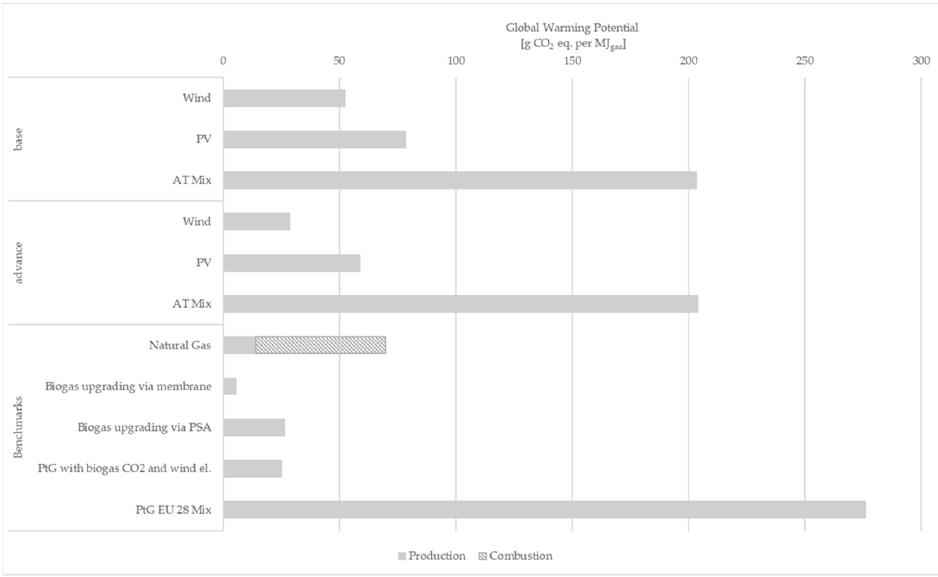
Figure 16. Global Warming Potential (GWP) for USC Scenarios compared to relevant benchmark processes (source: authors own based on GaBi ts 10 and ecoinvent v3.6 and [68–70]).